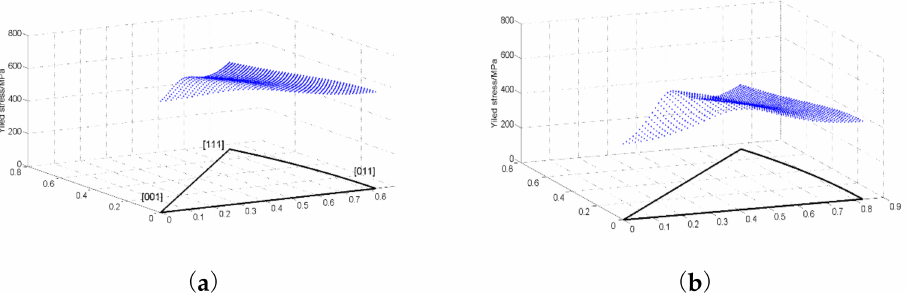
Figure 1. Yield strength of DD6 material at different temperatures. ( a ) DD6 material 980 ◦ C, ( b ) DD6 material 1070 ◦